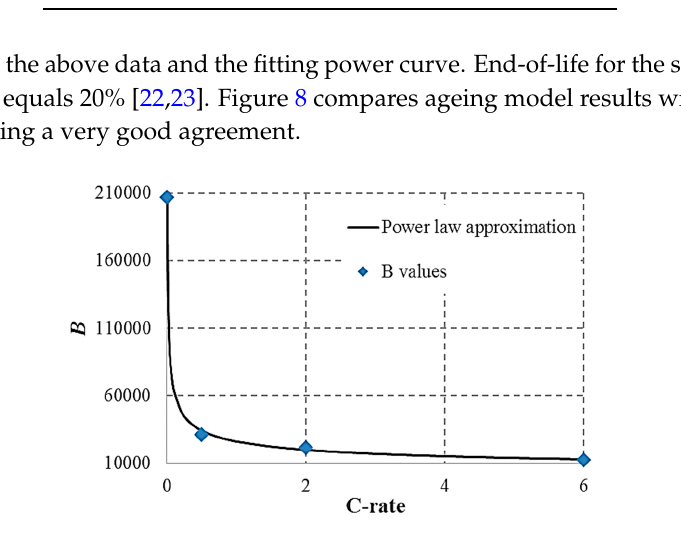
Figure 7. Experimental values [21] and fitting curve of B coefficient in the battery model (4), vs. C-rate .